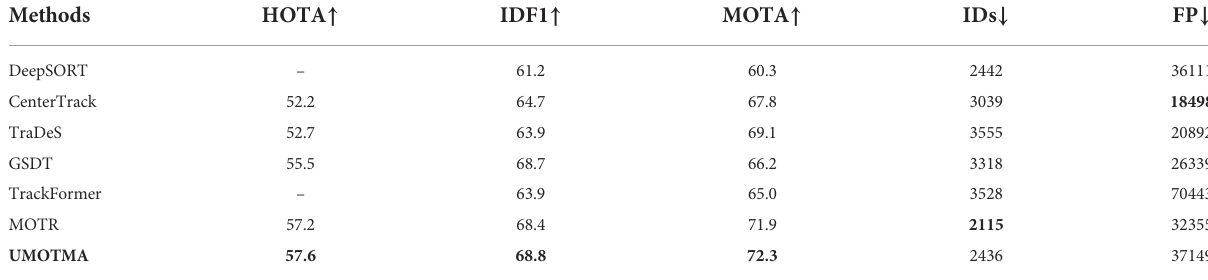
TABLE 6 Comparison of the state-of-the-art methods on the MOT17 test set.